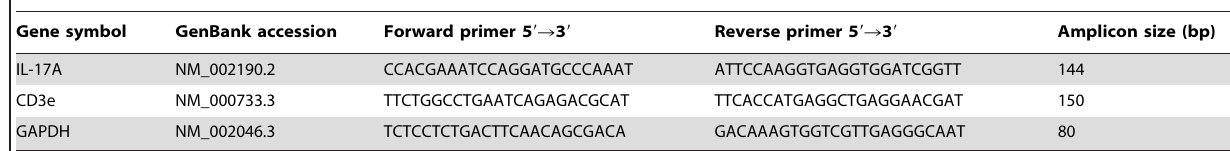
Table 2. Human primer sequences.